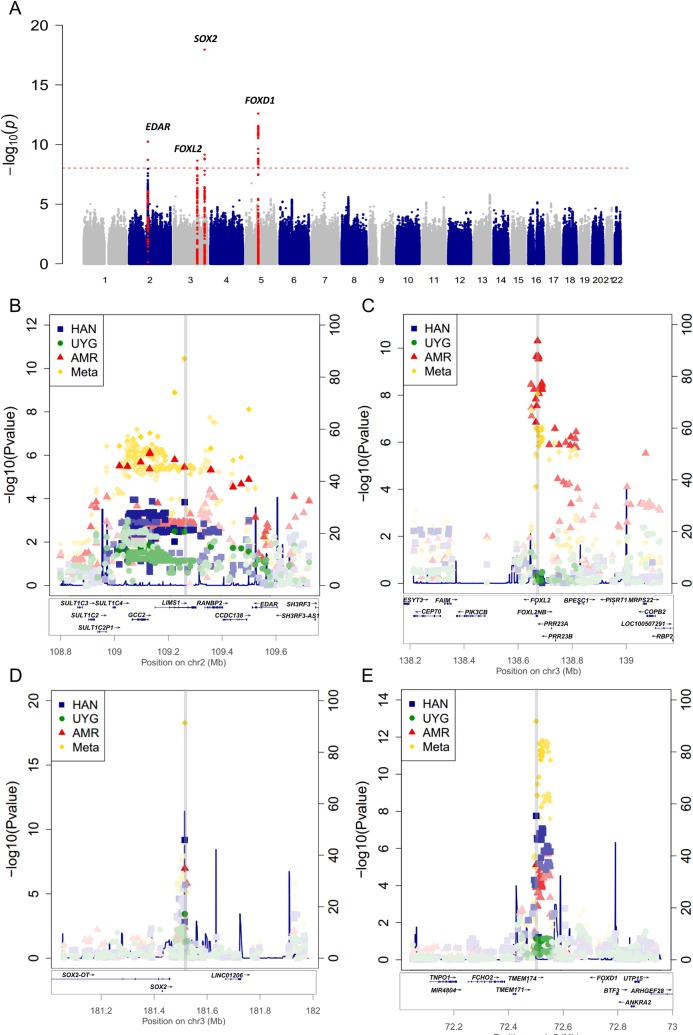
Manhattan plot showing the results of the GWAS meta-analysis for eyebrow thickness in Han Chinese, Uyghurs, and Latin Americans.A) Manhattan plot illustrating results of the transethnic meta-analysis of 2961 Han Chinese, 721 Uyghurs and 2301 Latin Americans. The red line indicates the threshold for genome-wide statistical significance (P<5×10−8). Red dots represent SNPs that are close (<5 kb) to the genome-wide significant signals. Regional association and linkage disequilibrium plots are shown for the significantly associated regions around B) rs1866188, C) rs112458845, D) rs1345417 and E) rs12651896 (gray bar). Different colors denote different populations. Increasing color intensities represent an increasing degree of linkage disequilibrium (r2) with the top SNP in each panel. The recombination rate (right-hand y axis) is plotted in blue and is based on the ASN population from the 1000 Genome Project. Exons for each gene are represented by vertical bars below the x axis, based on all isoforms available from the hg19 UCSC Genome Browser.